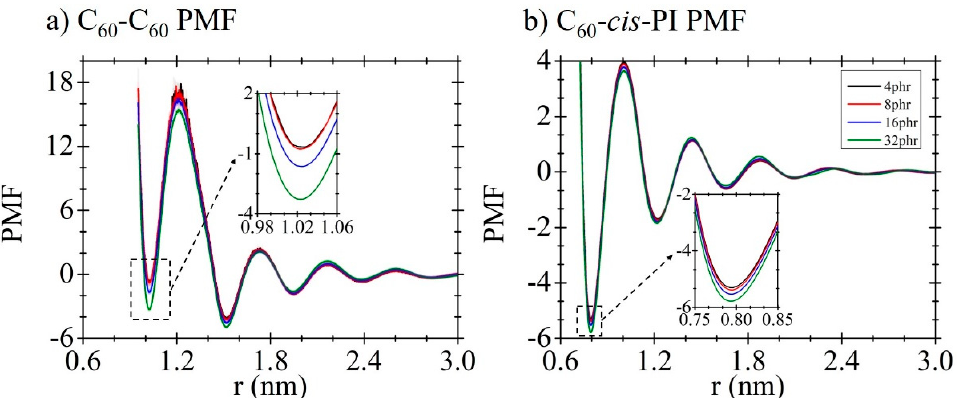
Figure 2. Potential of mean force (PMF) of ( a ) C 60 -C 60 and ( b ) C 60 - cis -PI in the composites at different C 60 concentrations.